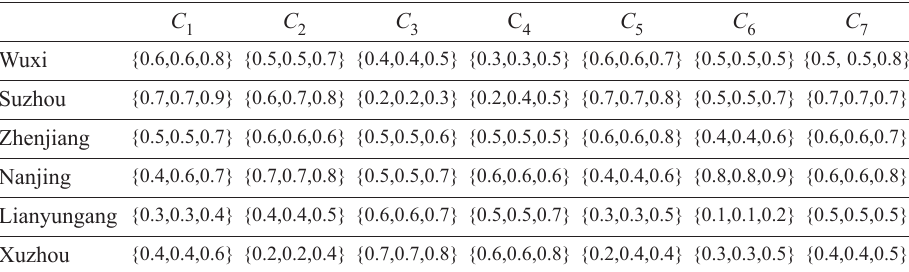
Table 6. Hesitant fuzzy decision